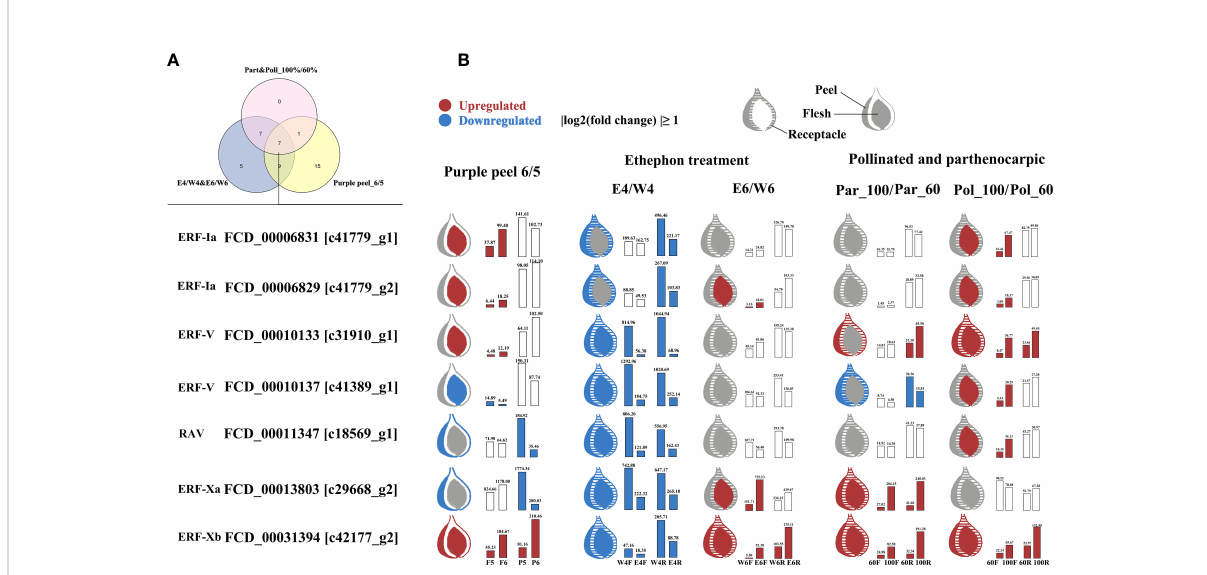
FIGURE 9 Summary of expression patterns for seven key FcAP2/ERF genes identi fi ed as differentially expressed in three transcriptomic datasets. (A) The intersection of FcAP2/ERF s differentially expressed in all three transcriptomic datasets. (B) Fruit ripening comparisons. The bar graph shows gene expression values in FPKM or